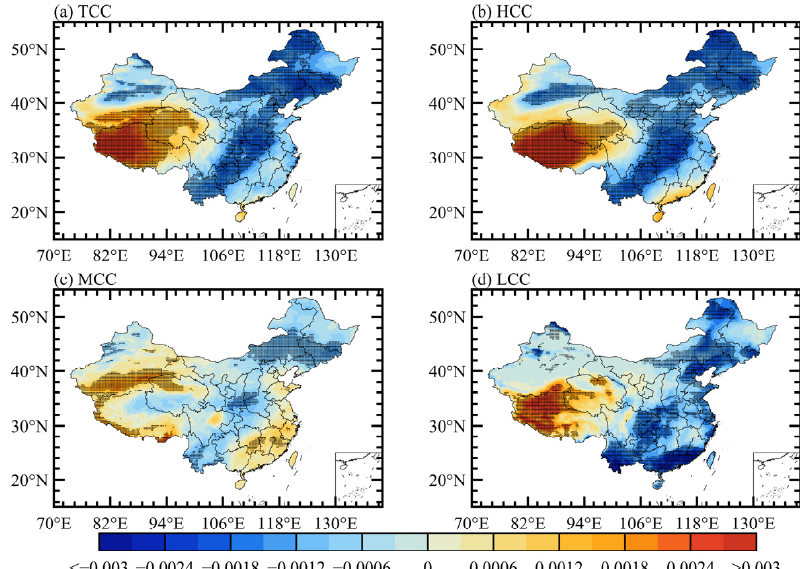
Figure 5. Spatial distribution of ( a ) TCC, ( b ) HCC, ( c ) MCC, and ( d ) LCC trends over China during the summers of 1979–2020 (unit: yr − 1 ). The stippled areas indicate that the trends passed the significance test at the 95% confidence level.